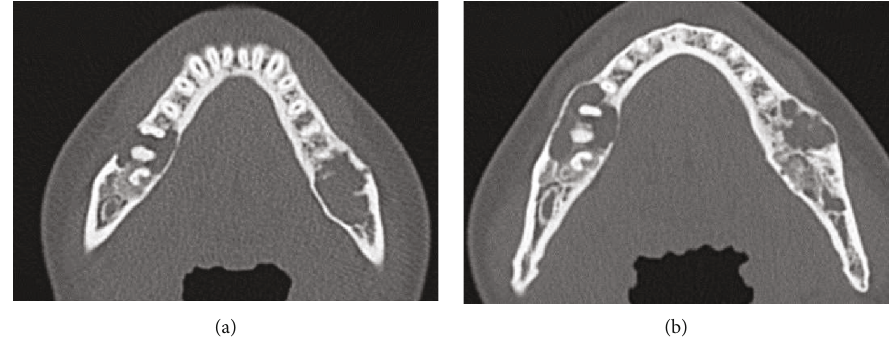
Figure 6: Follow-up CT images. (a) Three months and (b) twenty-seven months after the incisional biopsy; the CT images indicate enlargement of the right and an anterior half area of the left low-density lesions. CT: computed